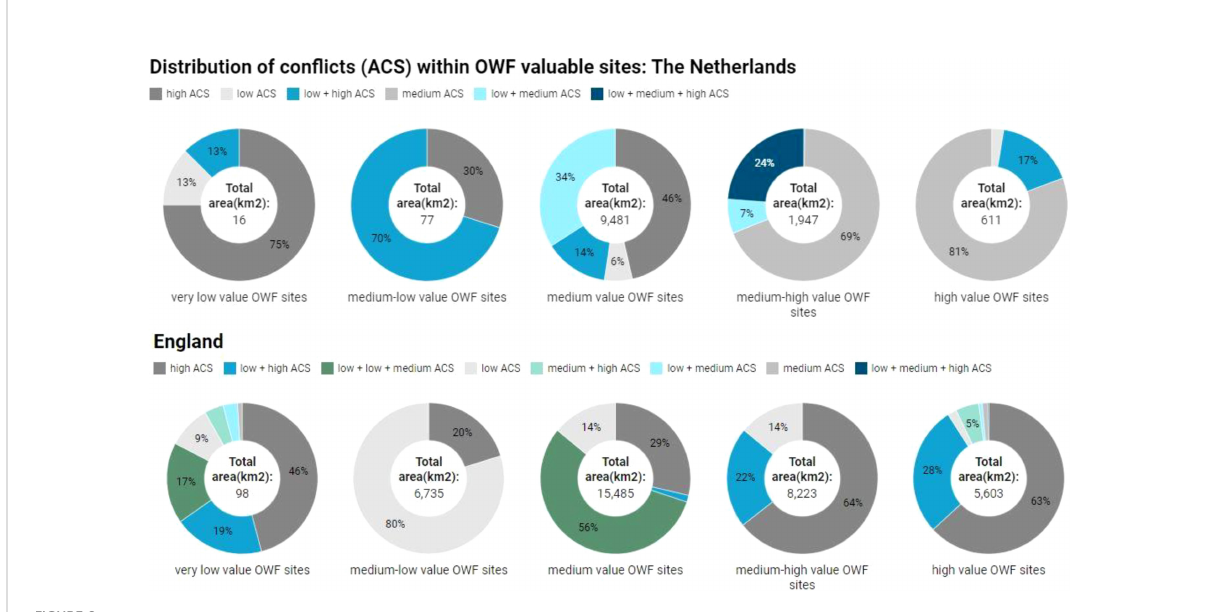
FIGURE 8 Average con fl ict resolution scores for the interaction between OWFs and nature protected